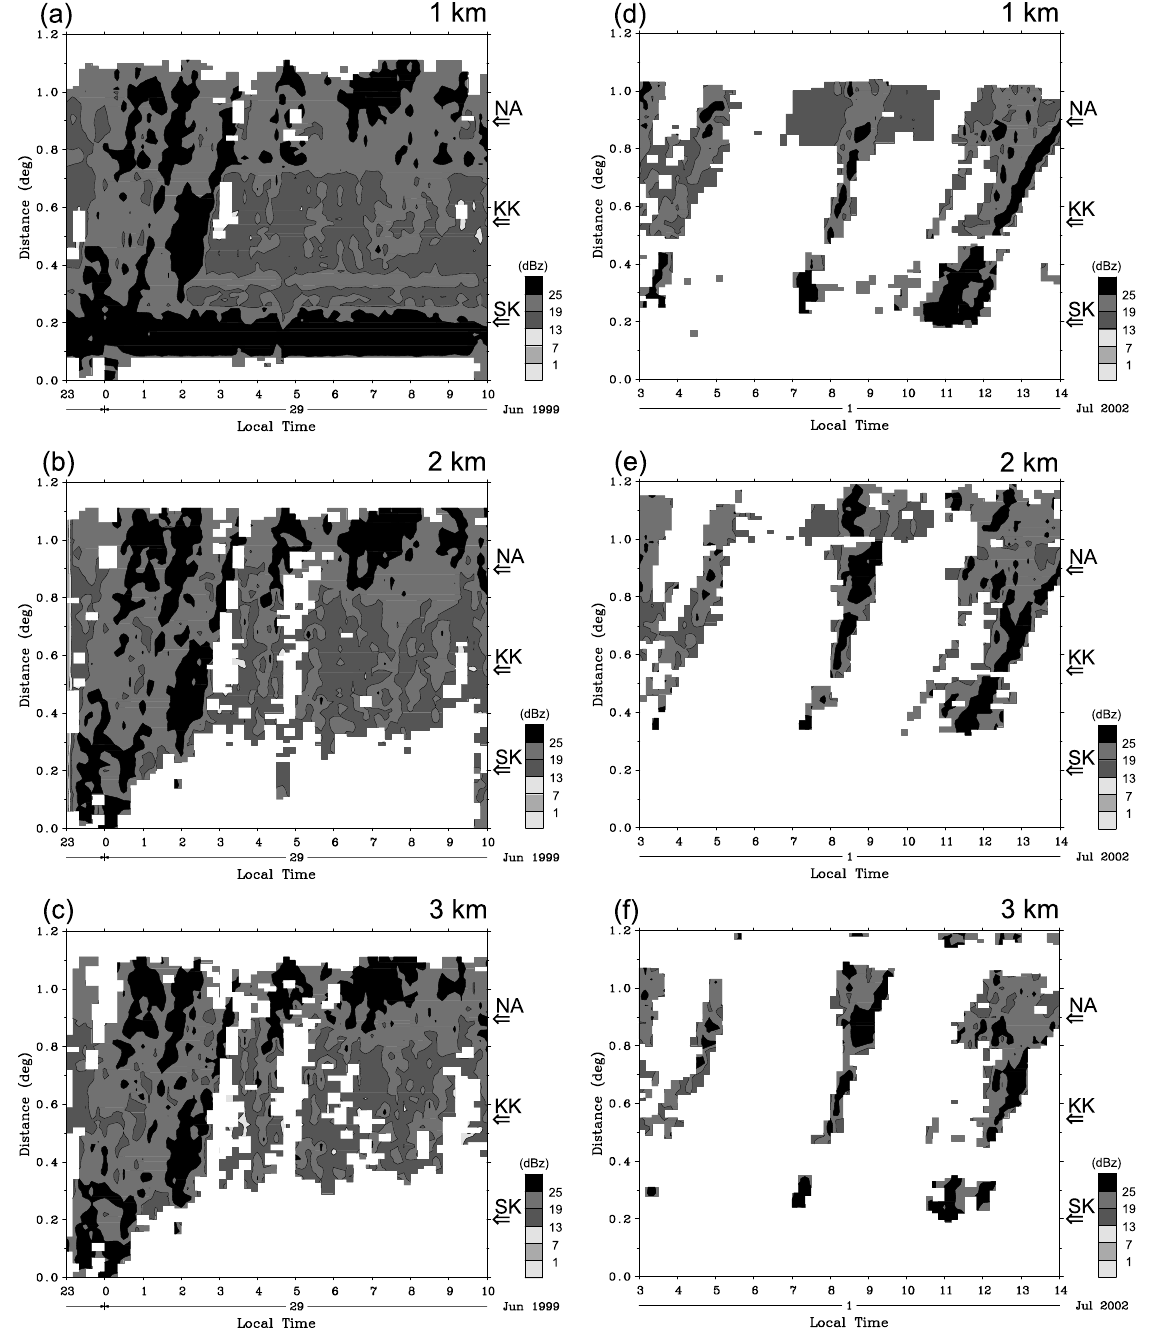
Fig. 6. Time series of the maximum rainfall intensity of an X-axis in a rectangle, as shown in Fig. 2, observed by X -band radar at SE on 28–29 June 1999 ( ( a ) – ( c ) ) and 1 July 2002 ( ( d ) – ( f ) ). A vertical axis corresponds to Y-axis in Fig. 2. Positions of NA, KK, and SK are indicated by arrows. See corrected section in